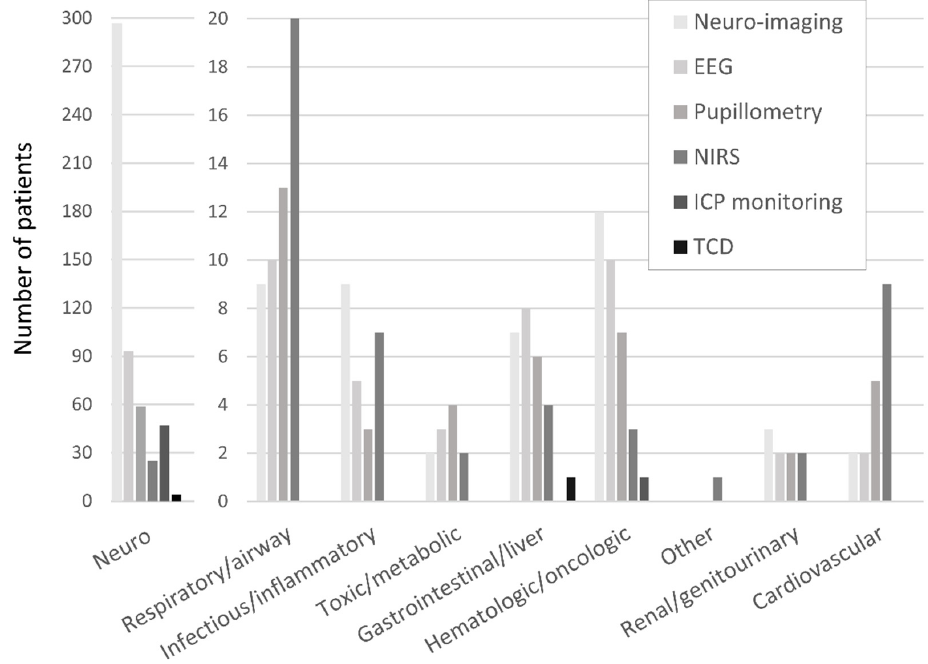
Figure 1. Neuro-imaging and neuromonitoring use by primary diagnostic category.